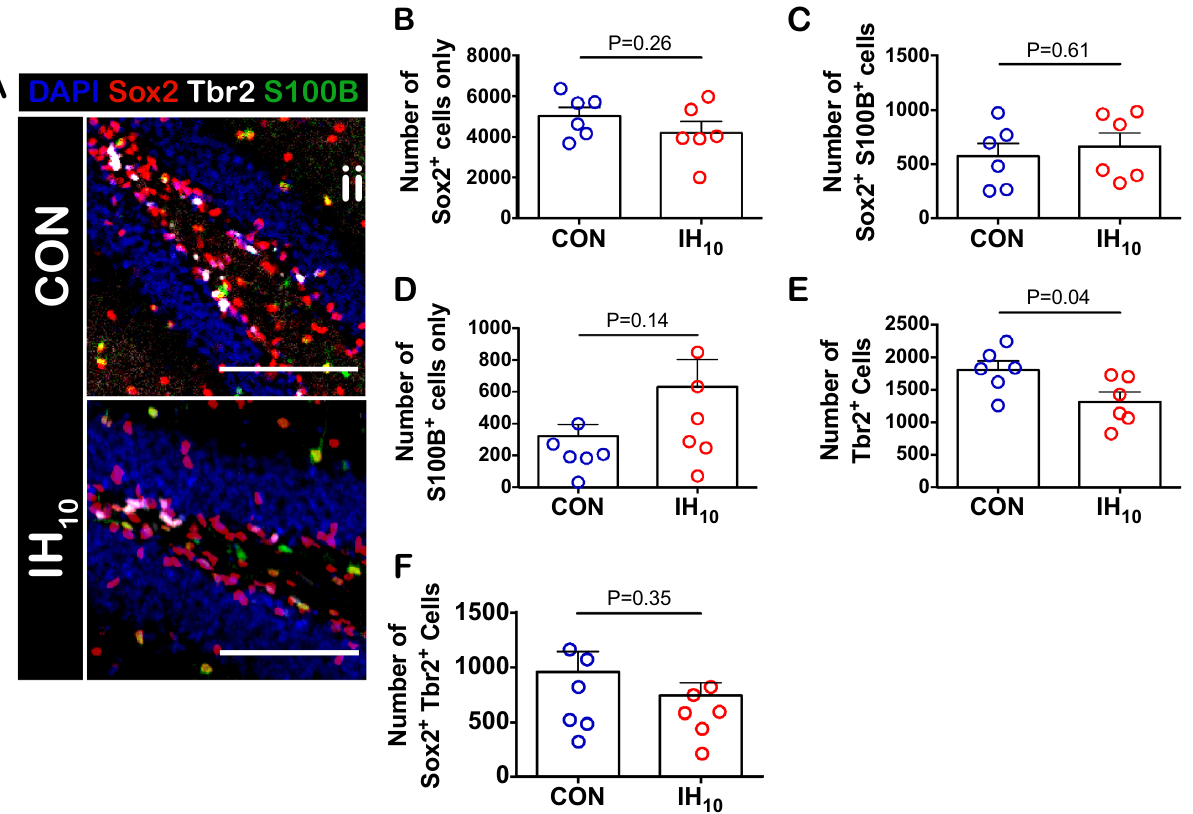
Figure 3. IH 10 suppresses the number of Tbr2 + cells in the SGZ. ( A ) Representative images of the SGZ from CON and IH 10 treated animals. Scale bars are 100 μm. ( B – D ) There were no differences in the number of pluripotent Sox2 + NSCs (CON: n = 6, IH 10 : n = 6), quiescent Sox2 + /S100B + co-labeled NSCs (CON: n = 6, IH 10